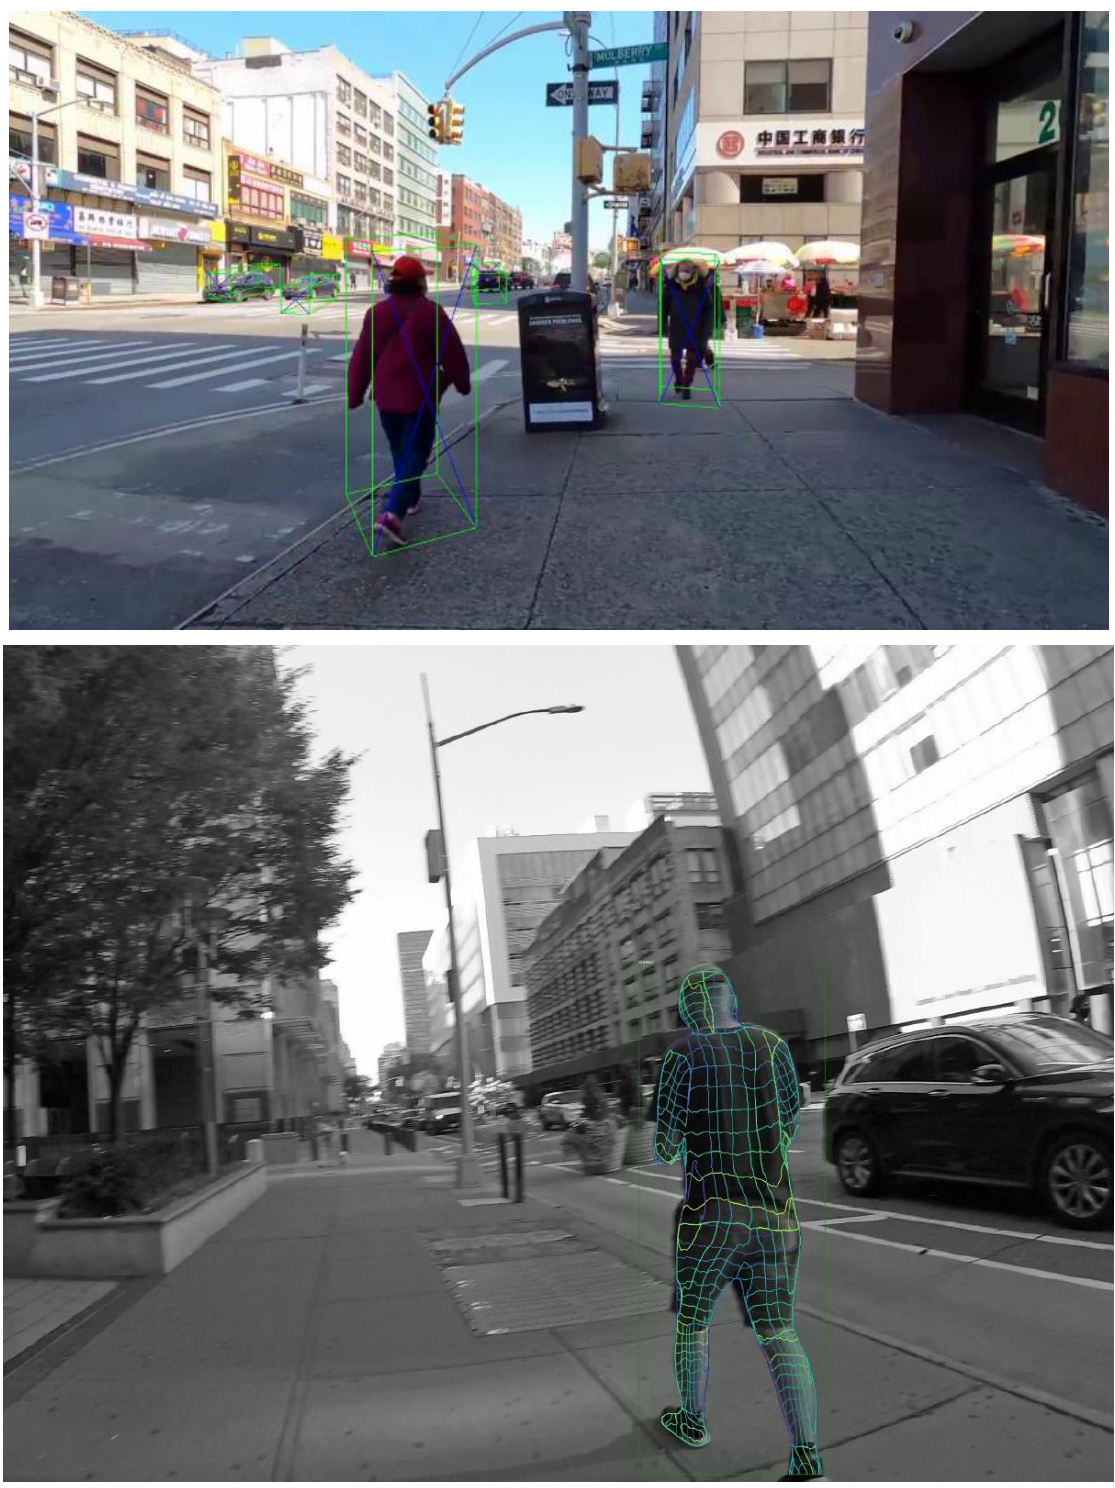
Figure 13. Pseudo-three-dimensional bounding ( top ) and mesh creation ( bottom ) of pedestrians and vehicles in a streetscape scene.